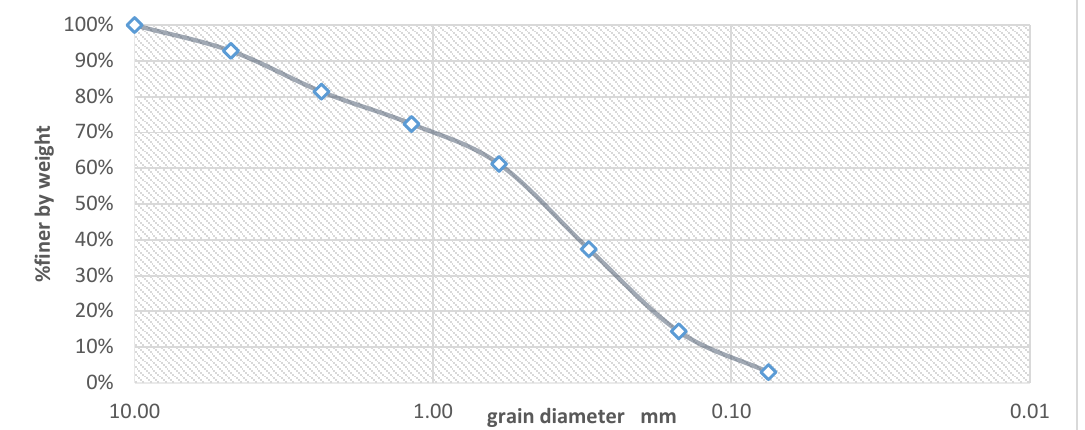
Fig. 1. Grain size distribution for used soil.